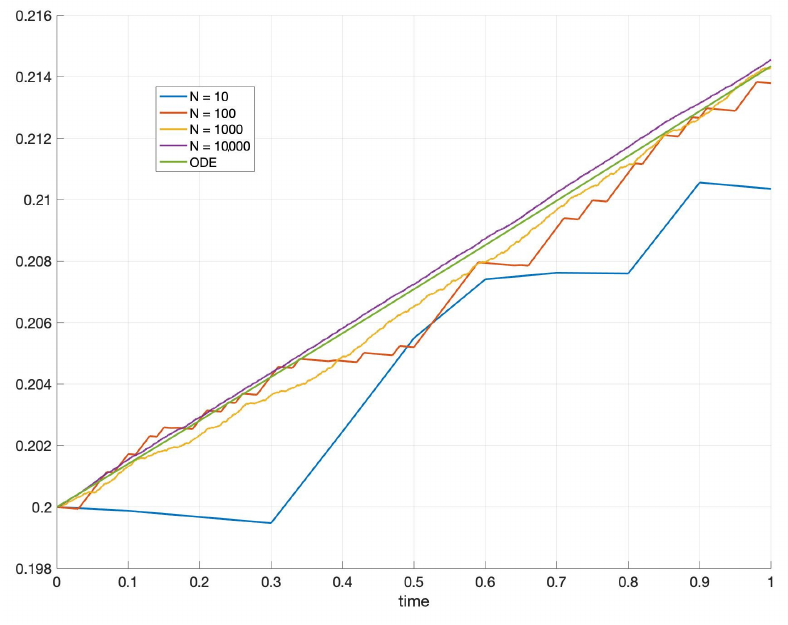
Figure 3. Plot of sample trajectories of ρ N green the trajectory of the solution of the deterministic ODE (62).